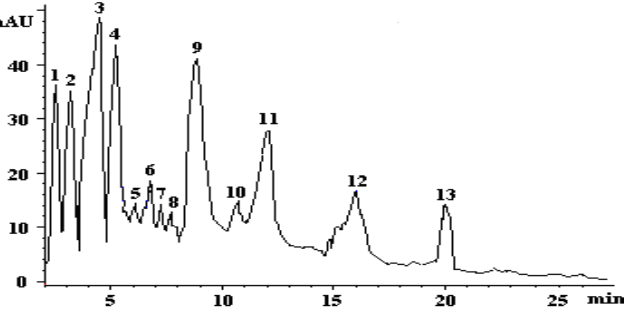
Figure 3. HPLC chromatogram of carotenoids in Penaeus kerathurus cephalothorax. The